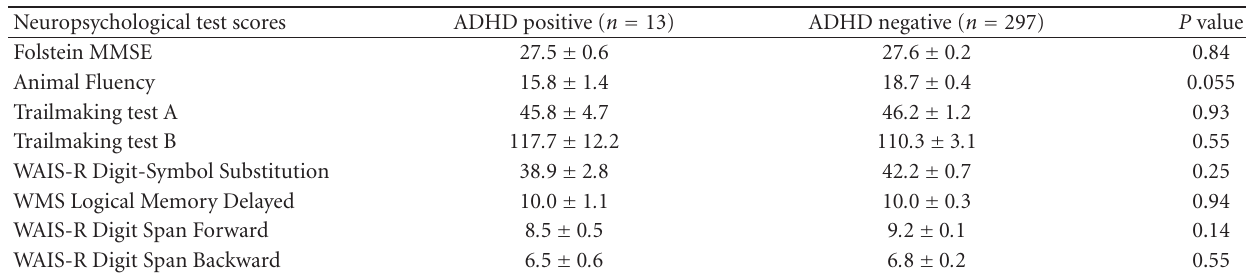
Table 2: Mean neuropsychological test scores ( ± SEM) adjusted for age, sex, education, and cognitive status in presumptive positive and negative childhood ADHD subjects as determined by Wender-Utah Rating Scale